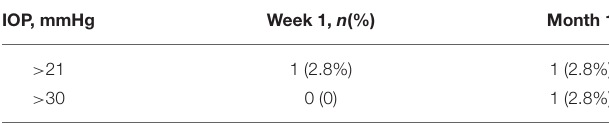
TABLE 5 | Number of eyes with IOP elevation at visits in the IVD